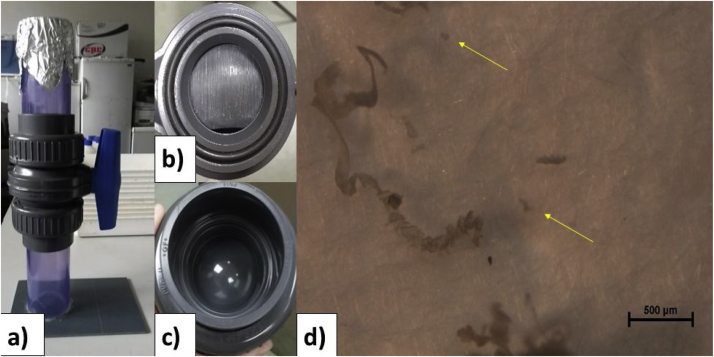
Sediment Microplastic Isolation unit constructed at the University of Birmingham (Image a); Ball valve after being used to process 20 sediment and blank samples showing striations (Image b); New ball valve showing no striations (Image c); Polyvinyl chloride shavings found in blanks. Yellow arrows show particles <200 μm (Image d). Note that similar shavings where found in field samples, suggesting that the smaller particles are likely also introduced into the field samples confounding any quantification.